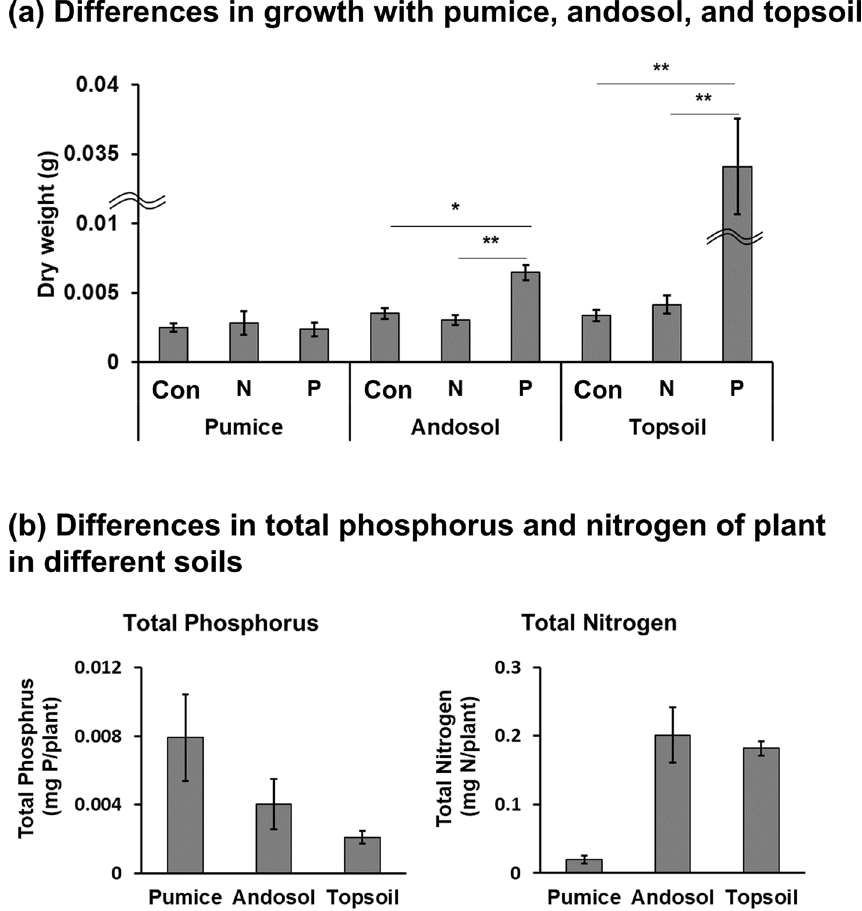
Figure 3. Verification of the effect of nutrients supplied from mature soil on plant growth. ( a ) Differences in growth of Fallopia japonica with pumice, andosol, and topsoil ( n = 4–8). ( b ) Differences in total phosphorus ( n = 4) and nitrogen ( n = 3) of F. japonica in different soils. The raw data are available in Supplementary Table S3. The figure’s value are mean ± SE. Kruskal–Wallis with post-hoc Steel–Dwass tests were used for ( a ) and ( b ). p values are * p < 0.05, ** p < 0.01. Phosphorus promoted F. japonica growth in andosol and topsoil. Total nitrogen was increased in plants cultivated in andosol and topsoil compared to that in pumice.